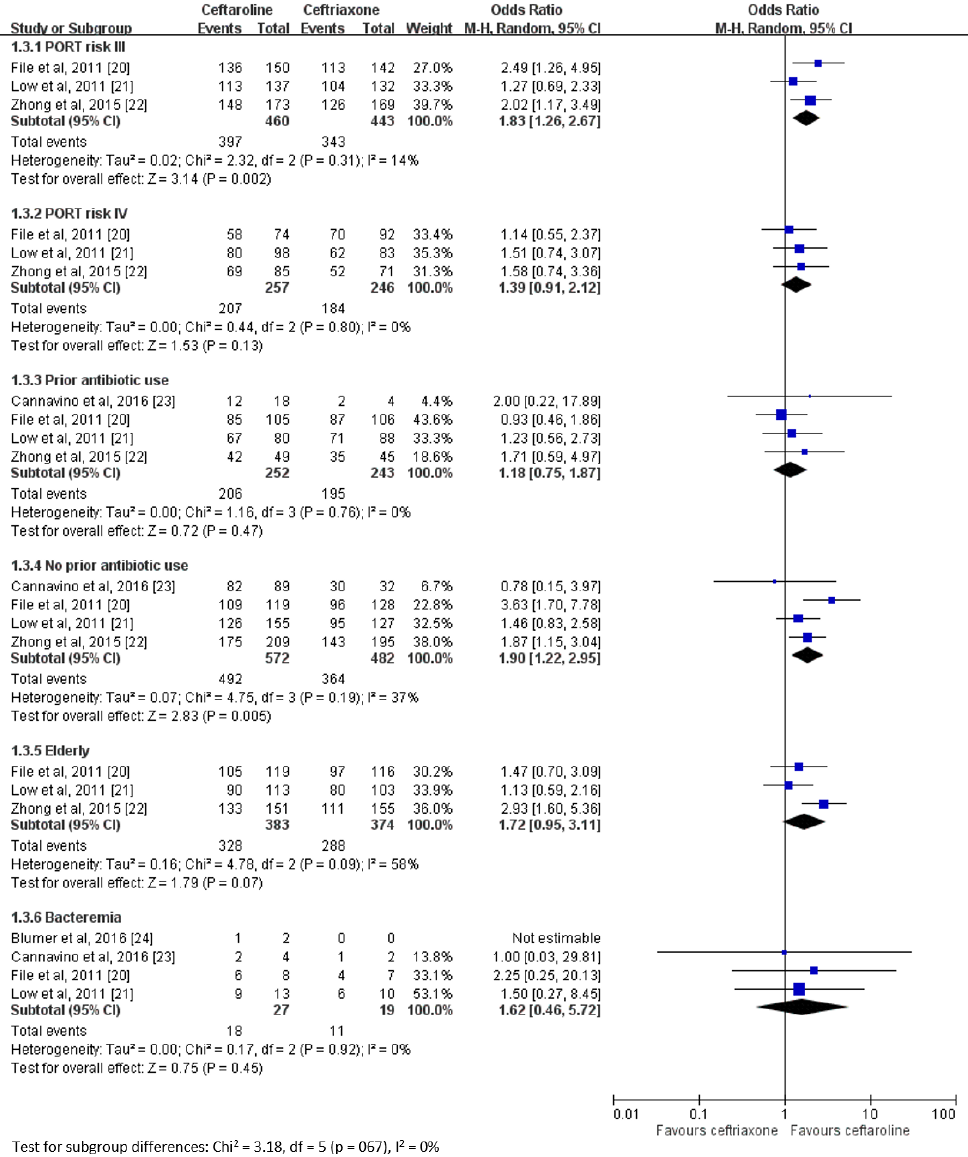
Figure 4. Overall clinical cure rates of ceftaroline and ceftriaxone for the treatment of community- acquired pneumonia based on patient group.